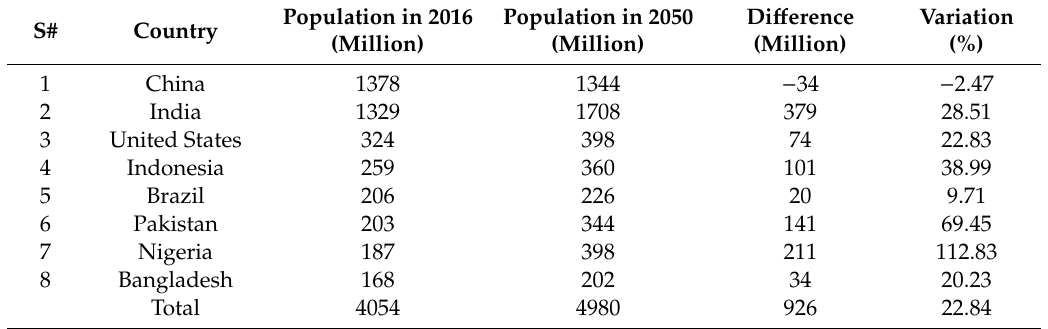
Table 2. Eight most populous countries in 2016 and their prospective population by 2050 (adapted from